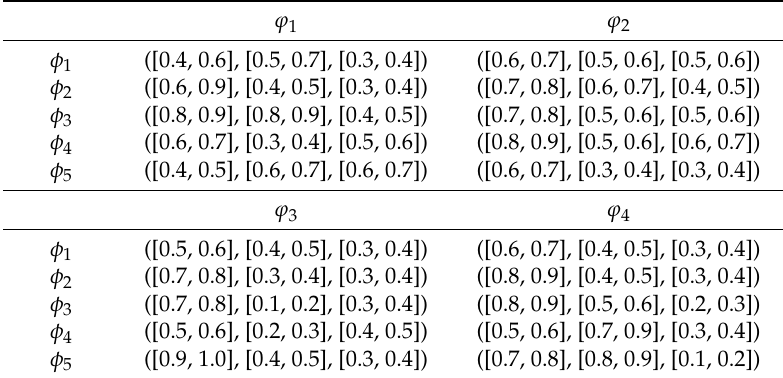
Table 2. The decision matrix (cid:101) R 2 .